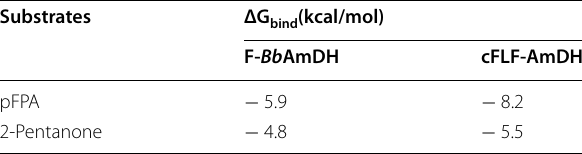
) of substrates and enzyme bind